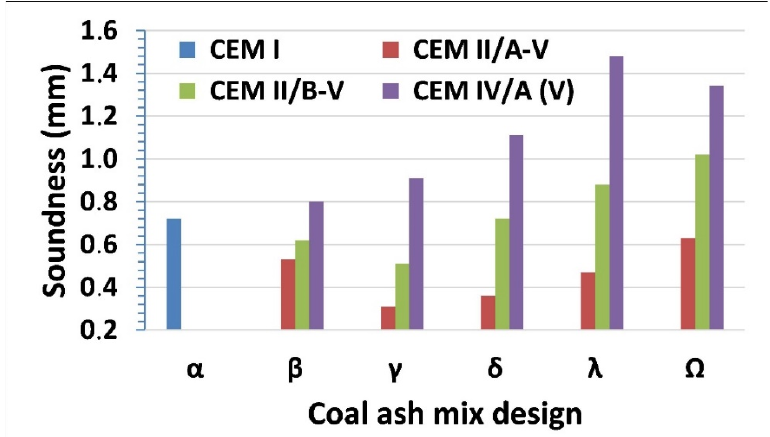
Figure 5. Coal ash cement paste properties: soundness.